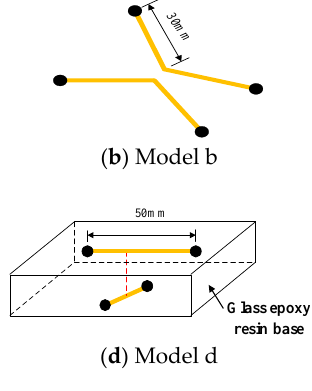
Figure 1. Electrode model of PCB.